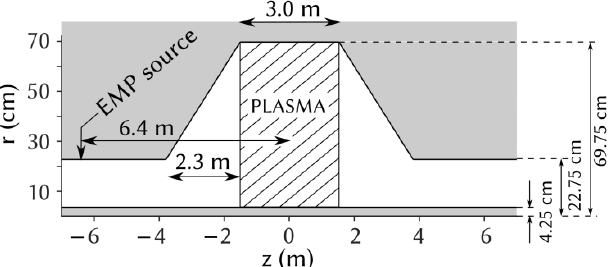
Figure 7. Geometry of the calculation area in the case of simulation of a plasma-filled coaxial line.